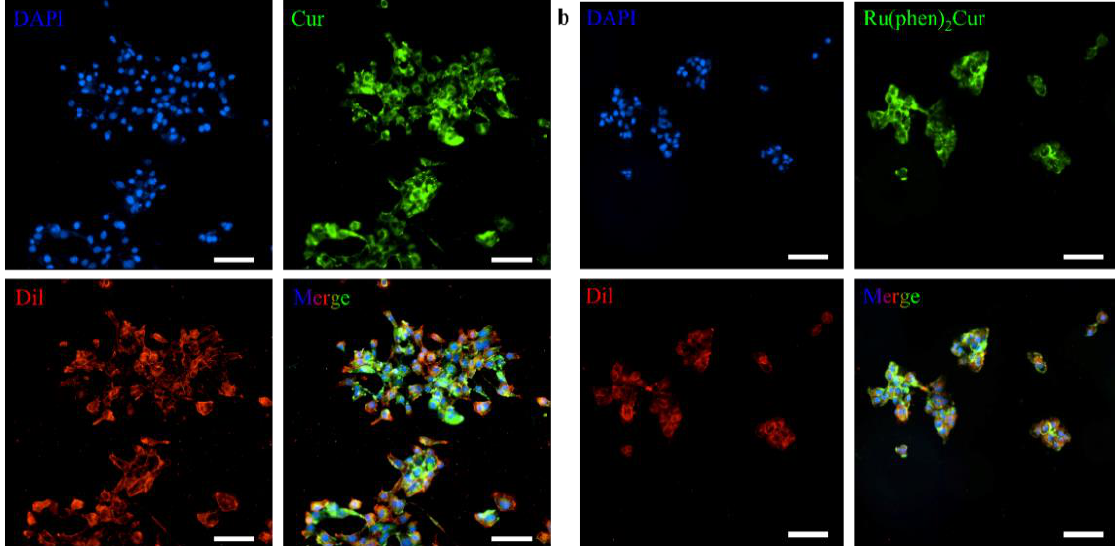
Figure 6. Luminescence confocal microscopy images of 4T1 cell membrane. ( a ) Fluorescence imag-